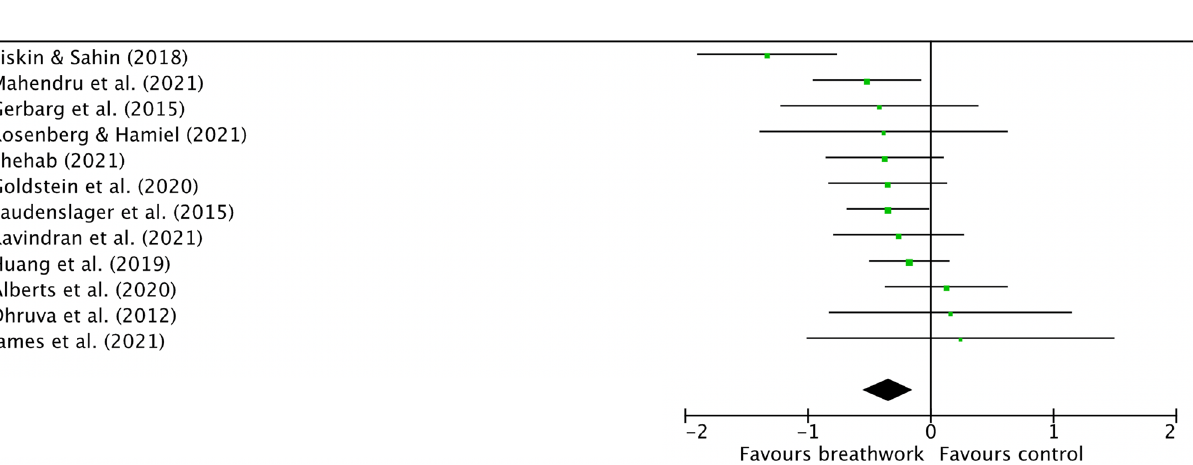
Figure 3. Forest plot comparing breathwork interventions to non-breathwork control groups on primary outcome of self-reported/subjective stress at post-intervention. Squares and their size represent individual studies and their weight, respectively. Lines through squares are 95% CIs and diamond is the overall effect size with 95% CIs. More negative values denote larger effect of breathwork on self-reported/subjective stress in comparison to control condition. Effect sizes calculated using Hedges’ g . Figure produced using RevMan